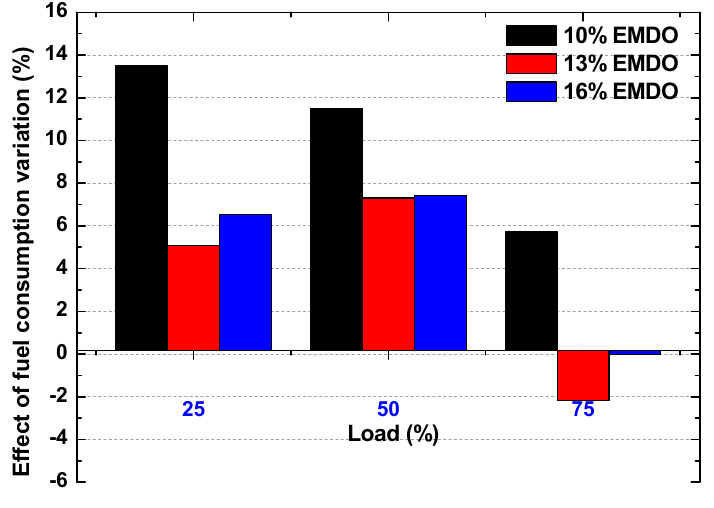
Figure 9. Fuel consumption without water with MDO and EMDO according to emulsified fuel ratio.